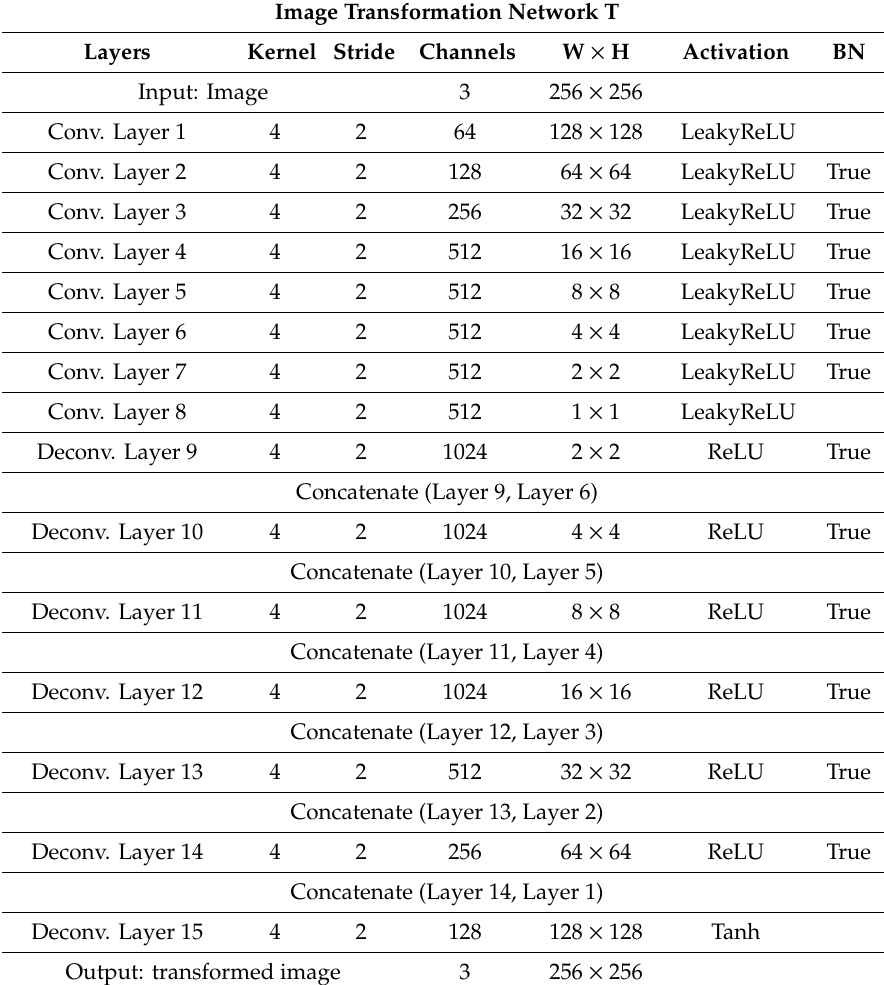
Table 1. The architecture of the Image Transformation Network T. Image Transformation Network T